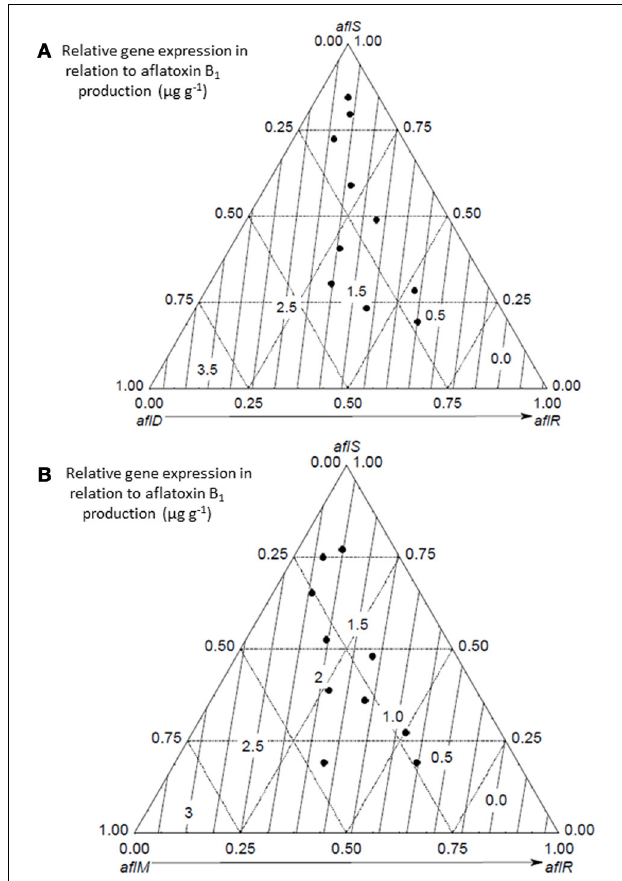
FIGURE 4 | Ternary diagrams of the relationship between the relative expression of the two regulatory genes (aflS,aflR) structural genes (aflD,aflM) on aflatoxin B 1 production ( μ g g − 1 ) (from Abdel-Hadi et al., 2012).